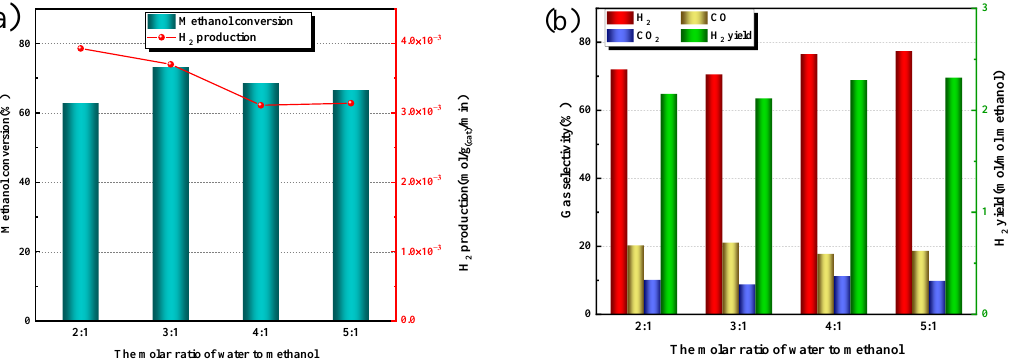
Figure 6. The MSR performance of the La 0.6 Sr 0.4 CeO 3- δ at different W/M: ( a ) methanol conversion (left Y) and hydrogen production of 1g catalyst (right Y); ( b ) gas selectivity (left Y) and hydrogen yield (right Y).